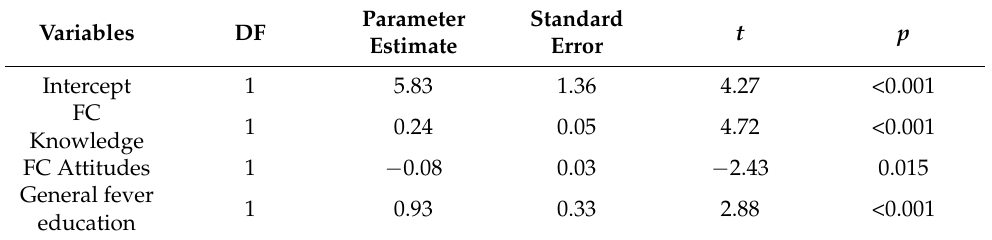
Table 5. Finalregressionmodeloftherelationshipbetweenfebrileconvulsionpracticesandothervariables.